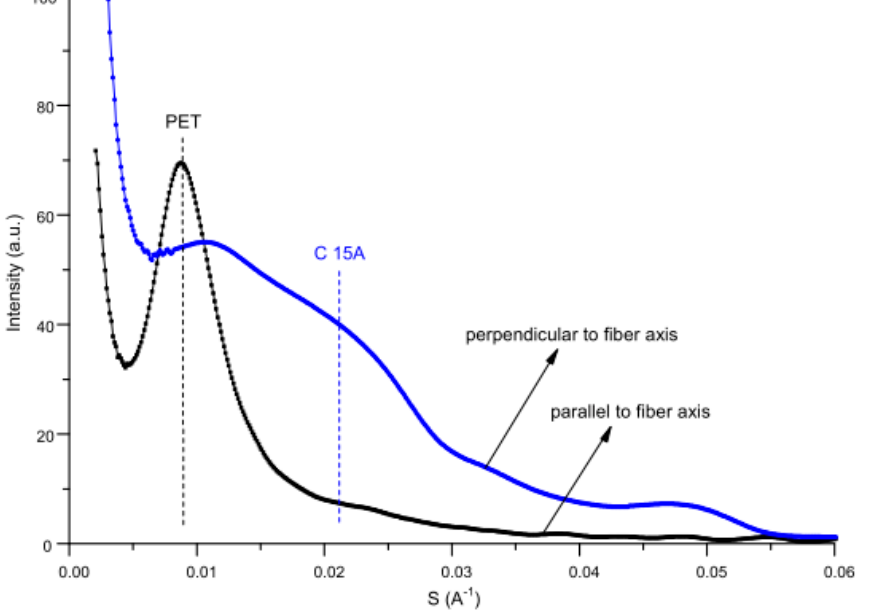
Figure 15. Comparison of small angle X-ray scattering (SAXS) curves taken in the direction parallel and perpendicular to the fiber axis for PET 130 + 7.5% C15A